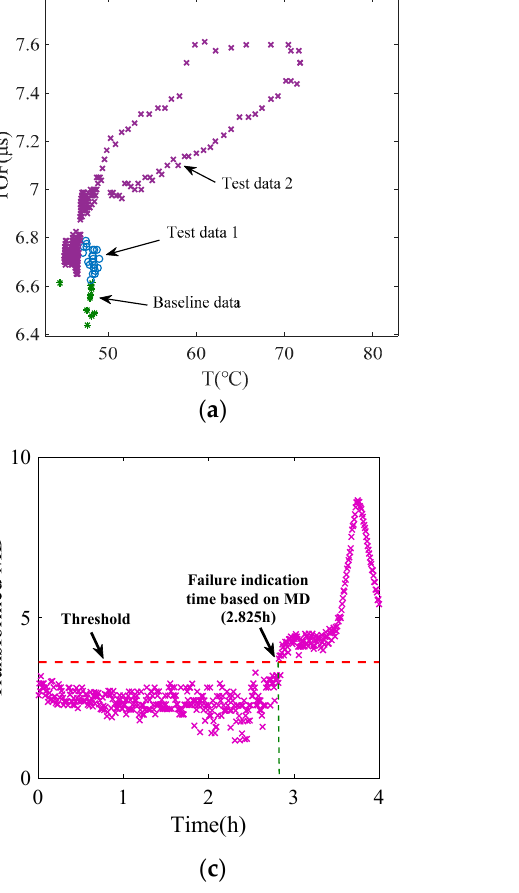
Figure 9. Health monitoring for battery A1: ( a ) scatter plot of the TOF and temperature, ( b ) degradation assessment result based on Mahalanobis distance (MD) values, ( c ) failure indication result based on MD values, and ( d ) failure indication result based on the temperature change rate.